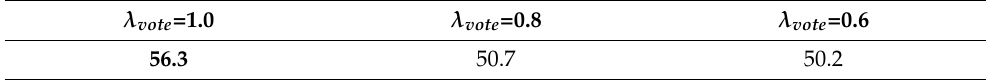
Table 6. Accuracy (%) of pseudo label generation threshold change experiment on M10 → S*10. λ vote =1.0